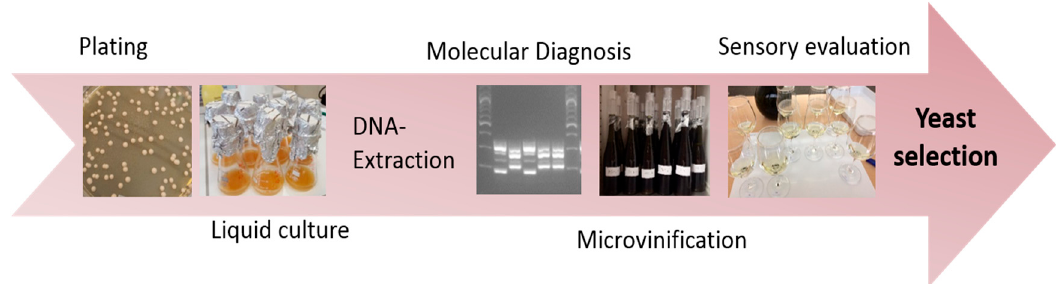
Figure 1. The progress of the yeast selection starting with the plating and ending with a yeast for a winery in order to ensure its spontaneous fermentation.